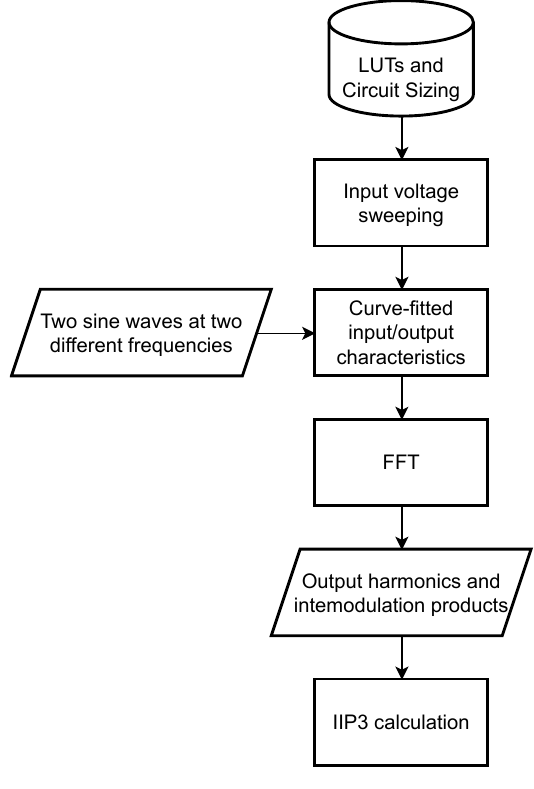
Figure 4. Non-linearity calculation algorithm.